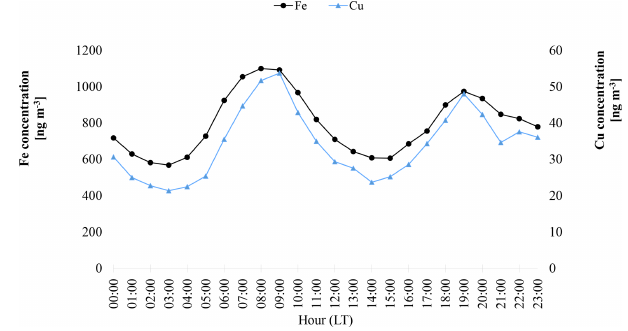
Figure 1. Diurnal profile of Fe and Cu concentrations (in ngm − 3 ).